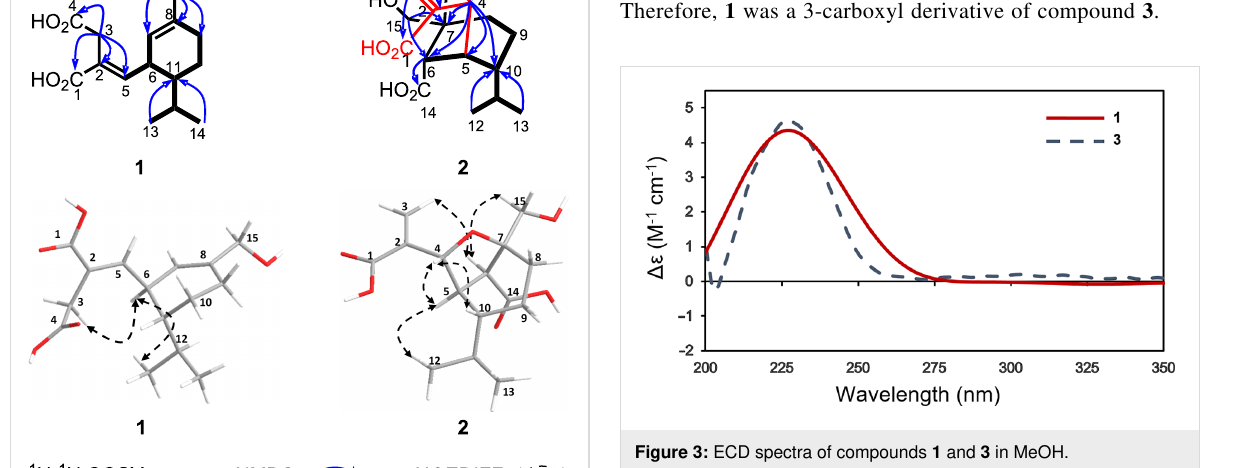
absolute configurations at both C-6 and C-11 of compound 1 . Therefore, 1 was a 3-carboxyl derivative of compound 3 .